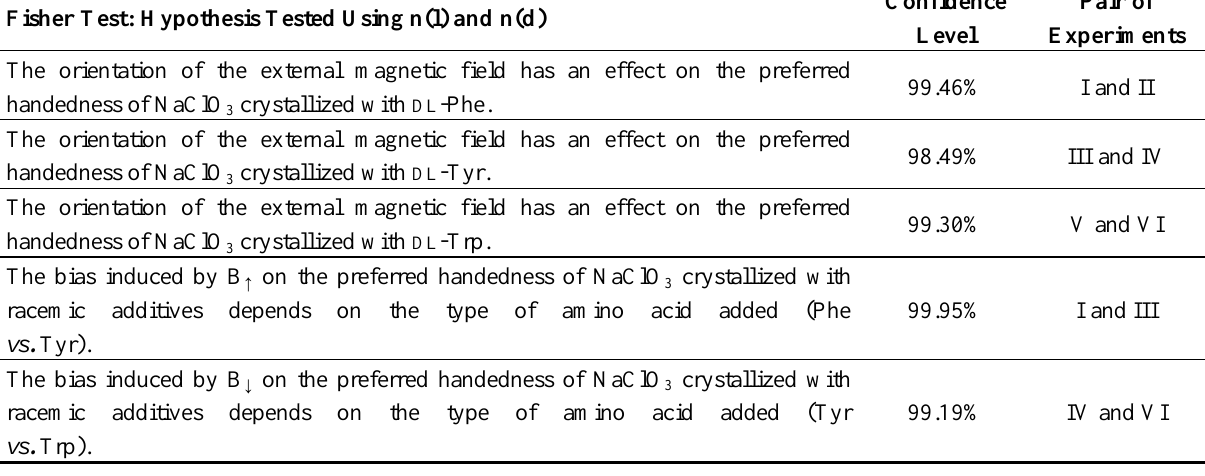
Table 3. By applying the Fisher test to pairs of experiments of Table 2 where only one condition is changed all hypotheses with confidence level above 95% are